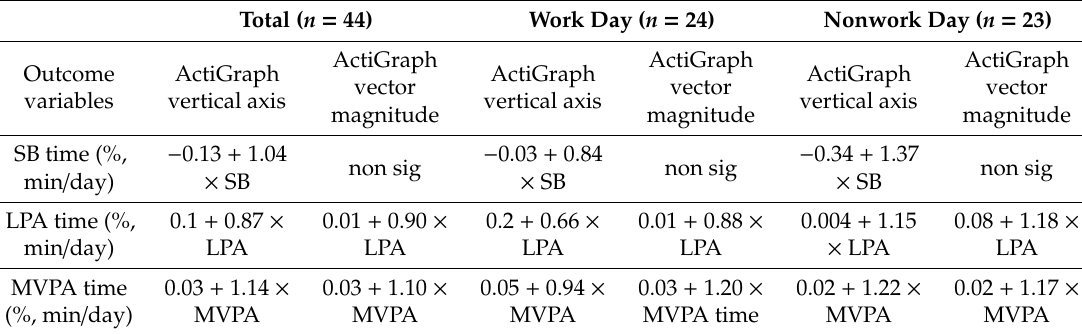
Table 4. The correction factors based on the linear